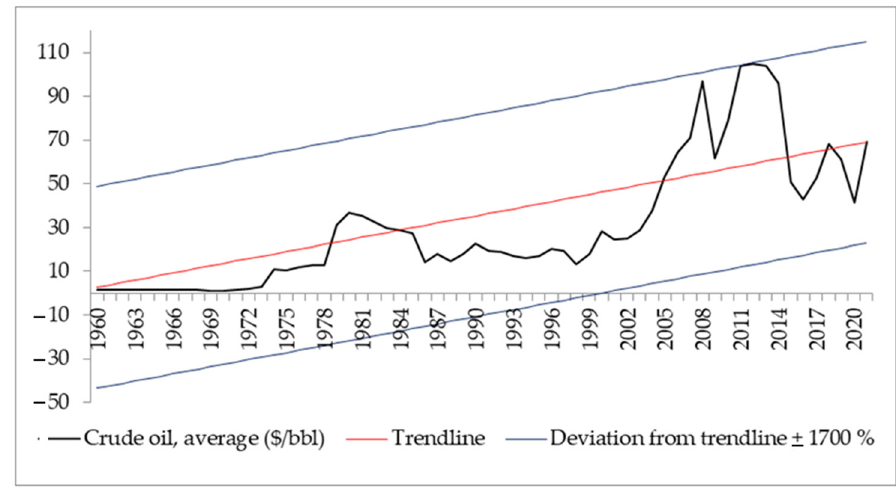
Figure 2. Average annual crude oil price from 1960 to 2021 (USD per barrel).